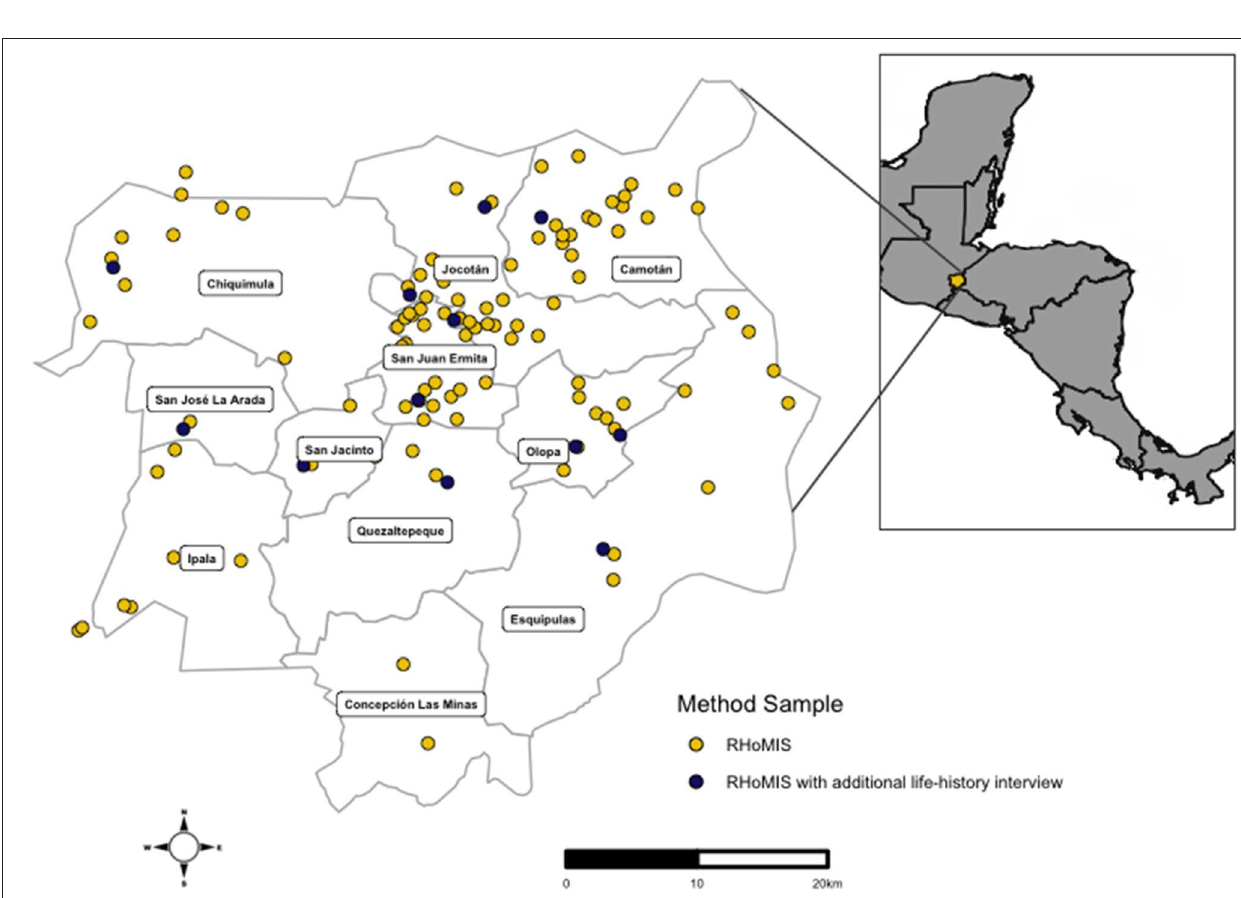
FIGURE 1 | Municipality boundaries in the Chiquimula Department of Guatemala, Central America. Points show the locations (with jitter) of communities included in the Rural Household Multi-Indicator Survey sample (yellow) and communities where households were selected for additional life-history interviews (blue).